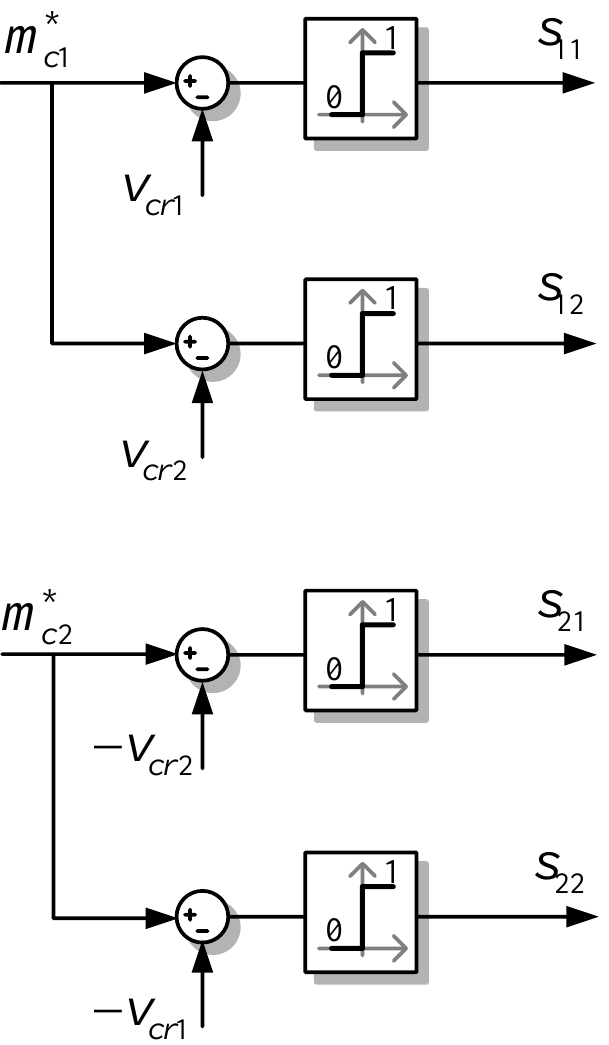
Figure 3. Straightforward implementation of hybrid LS-PWM and PS-PWM modulation for a 5L-CTNPC